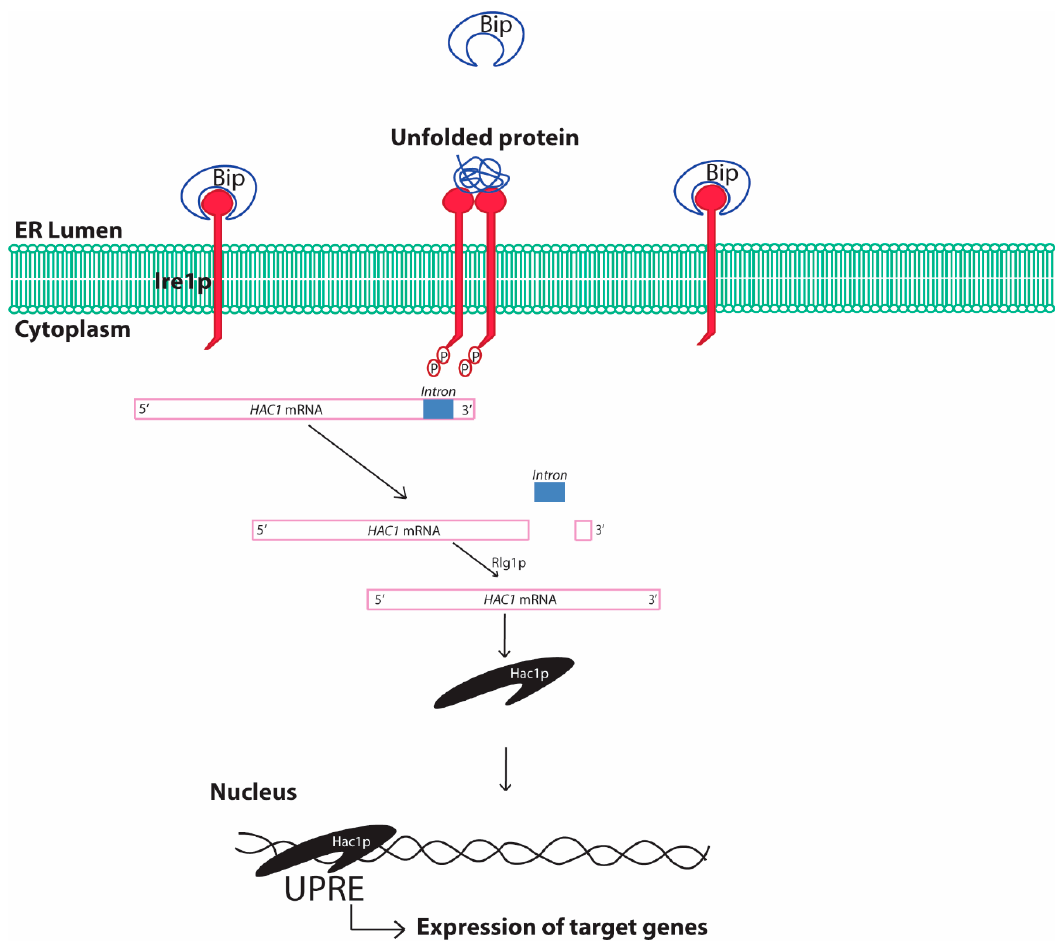
Figure 3. Schematic diagram showing unfolded protein response in yeast cells. Bip, binding immunoglobulin protein; ER, endoplasmic reticulum; Ire1, inositol requiring element 1; HAC1, Homologous to ATF/CREB1; Rlg1p, tRNA ligase protein; UPRE, unfolded protein response elements. The presence of unfolded/misfolded proteins in the ER lumen is recognized by the yeast Ire1 sensor protein that activates the specific cytosolic endonuclease activity cleaving the inhibitory intron of HAC1 mRNA and rendering HAC1 mRNA translationally active. Hac1p protein translates and translocates to the nucleus, where it recognizes the characteristic cis ‐ acting elements in the promoter regions of certain genes referred to as UPRE and increases expression of genes under control of such promoters. The process is referred to as the UPR.